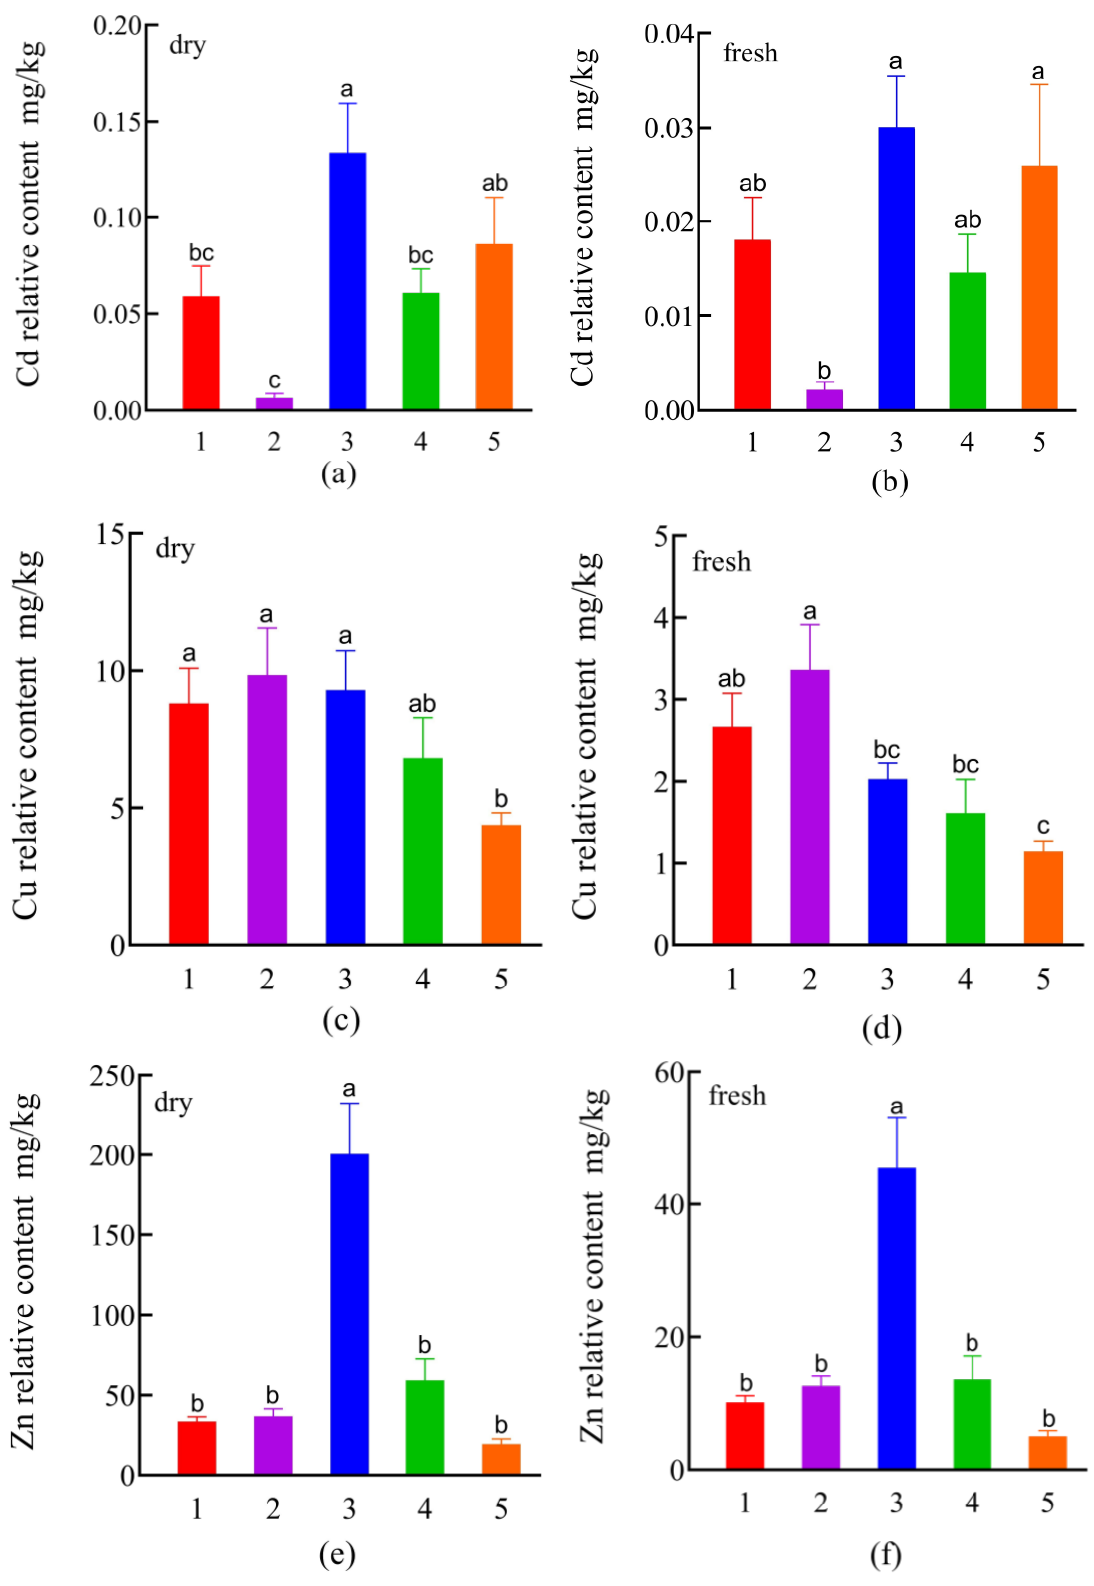
Figure 7. Significant analysis diagram of heavy metal content in different parts of PsR : ( a ) Cd in the dry state; ( b ) Cd in the fresh state; ( c ) Cu in the dry state; ( d ) Cu in the fresh state; ( e ) Zn in the dry state; ( f ) Zn in the fresh state. Note: 1—old leaf, 2—young leaf, 3—upper stem, 4—middle stem, 5—lower stem.